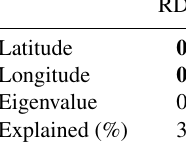
Table 2. Results of the redundancy analysis (RDA). Variables that are significantly correlated (P <0.01) with the RDA axes are shown in bold. RDA1 RDA2 Latitude 0.88 − 0 . 47 Longitude